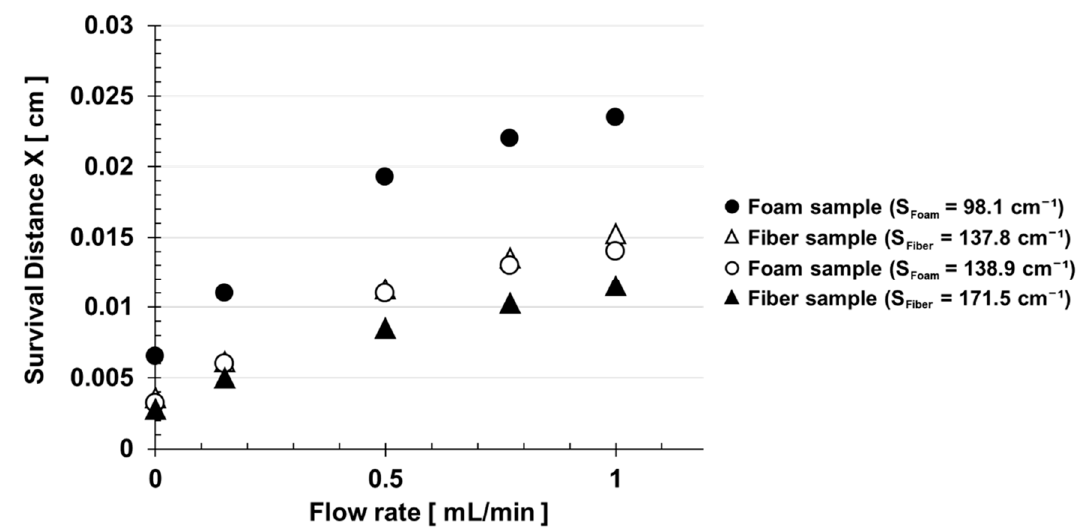
Figure 3. Survival distance in the stream-wise direction as a function of perfusion flow rate and scaffold architecture. Data is plotted for the limiting case of the fully reactive Lagrangian Scalar Tracking (rLST) particles.